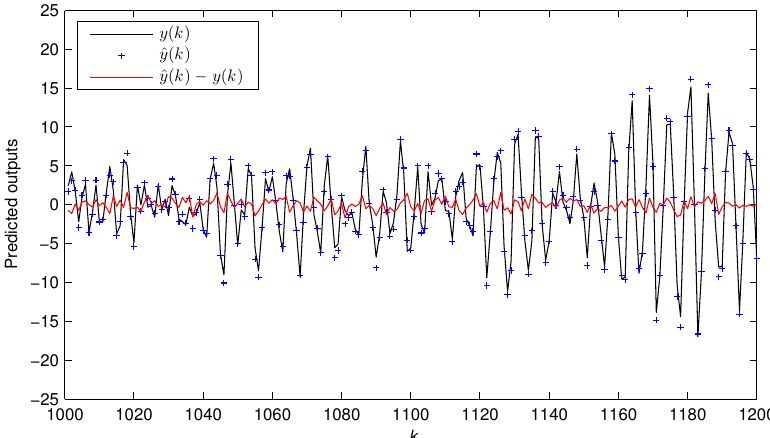
Figure 5. The actual output y ( k ) and the estimated output ˆ y ( k ) versus k for Example